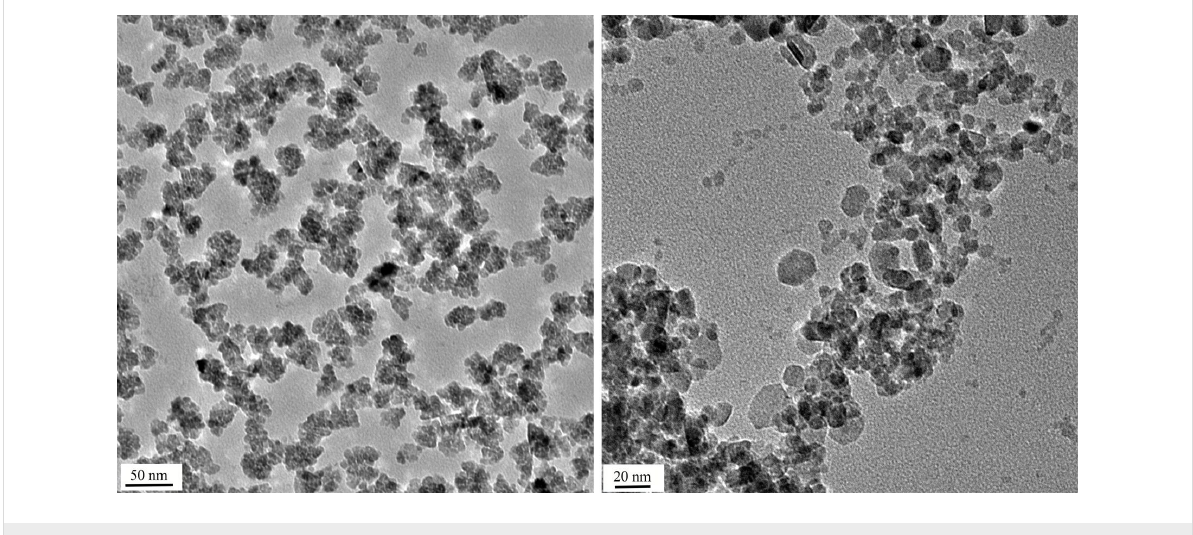
Figure 1: Left: ZnO-NP prepared by the acidic procedure (sample 1 , without labelling; scale bar: 50 nm). Right: ZnO NP prepared under alkaline conditions (sample 2 , without labelling; scale bar: 20 nm).